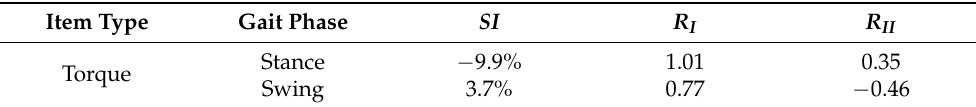
Figure 12. The intact knee angle and the prosthetic knee angle. Table 4. The knee angle symmetry. Item